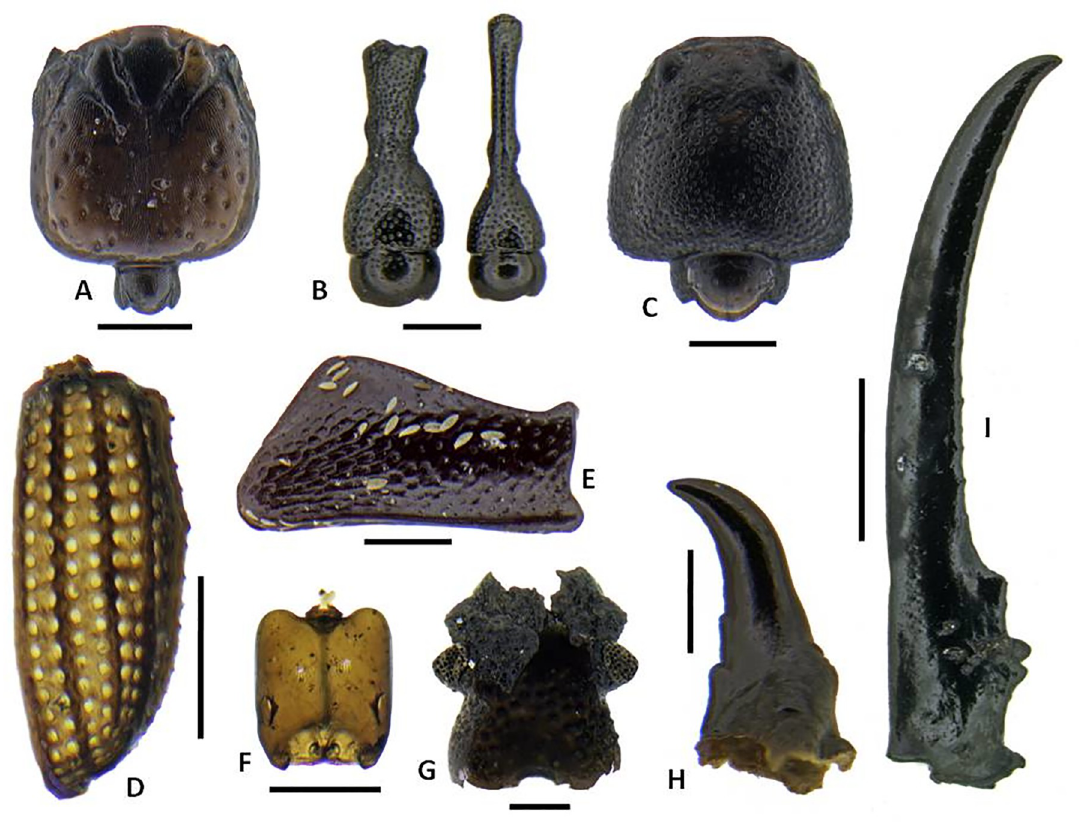
(Curcuclionidae) weevil hind femur; F. Platyscapa (Agaonidae) fig wasp head; G. Proterhinus (Belidae) weevil head; H. Cryptotermes dolei (Kalotermitidae) termite mandible; I. Chelisoches morio (Chelisochidae) earwig forcep. Scale bars: A-H, 0.25 mm. I, 2 mm. (Photo by N. Porch).